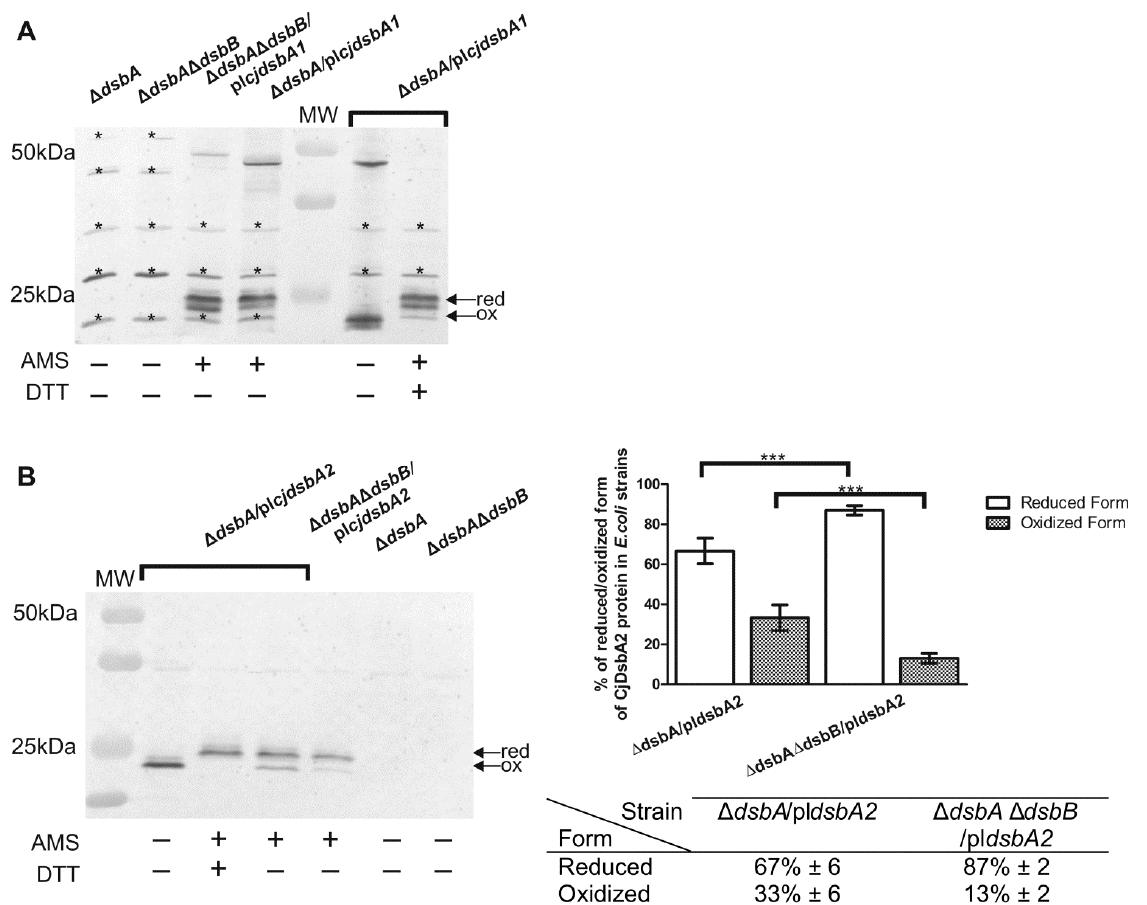
Figure 6. CjDsbA1 ( A ) formed dimers in E. coli cells. Monomeric CjDsbA1 was present in two reduced forms in both ∆ dsbA and ∆ dsbA ∆ dsbB, whereas dimeric CjDsbA1 seemed to be present in oxidized form in ∆ dsbA E. coli. CjDsbA2 ( B ) was present in both oxidized and reduced forms in E. coli lacking dsbA and mainly in reduced form in E. coli ∆ dsbA ∆ dsbB . Table and plot present quantitative analysis of equilibrium of reduced and oxidized forms of CjDsbA2 in various E. coli strains. Proportion of reduced and oxidized forms of CjDsbA2 was estimated using Image Lab™ (Bio-Rad) and evaluated using t -test (*** p < 0.0001) based on three independent experiments. Bacterial cell cultures were treated with 10% TCA (trichloroacetic acid) and AMS (4-acetamido-4 ′ -maleimidylstilbene-2,2 ′ -disulfonic acid). The controls were reduced (red; treated with DTT and AMS) and oxidized (ox; untreated with AMS) proteins. Samples were electrophoretically separated under non-reducing conditions using 16% polyacrylamide gels with sucrose addition. Then, Western blot analyses using specific anti-CjDsbA1 or anti-CjDsbA2 serum were performed. Three independent experiments were performed ( n = 3). The figure presents a representative result. *—unspecific serum reaction; MW refers to lane with molecular weight marker.